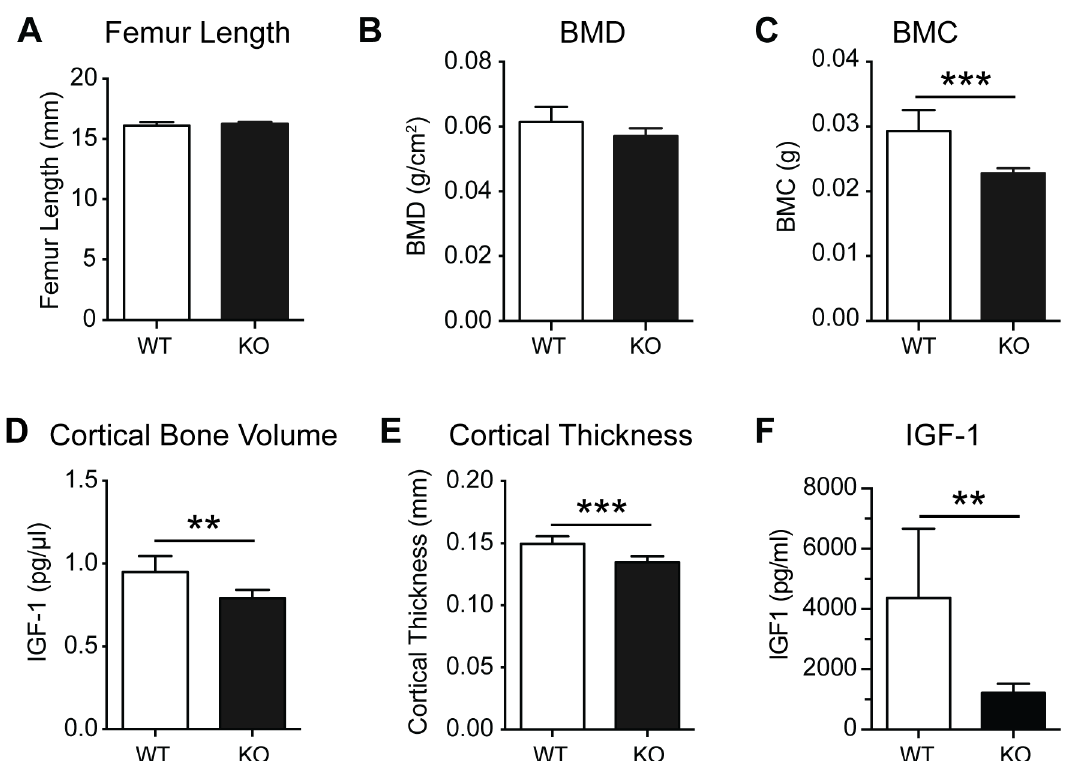
Fig 5. Bone characterisation of aged PWCR KO mice. A.) Femur length of 35 week old male WT and PWCR KO mice; B.) BMD and C.) BMC measured by DXA of isolated femurs; Three-dimensional μ CT analysis of cortical and cancellous bone D.) cortical bone volume; E.) cortical thickness; F.) IGF-1 n = 6 represented as mean ± SD. ** p-value < 0.01, *** p-value < 0.001.